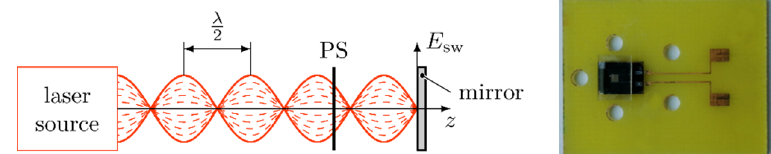
Figure 1. ( Left ) electrical field intensity (cid:1831) (cid:3046)(cid:3050) of a standing wave and detection by a transparent photo sensor (PS, right ). (cid:1831) (cid:3046)(cid:3050) (cid:3404) 0 at the mirror surface at all times. Dashed lines indicate the time dependency of (cid:1831) (cid:3046)(cid:3050)